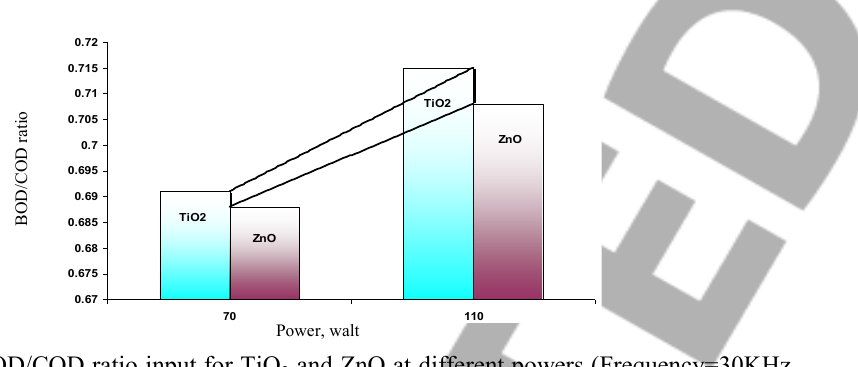
Figure 2 . BOD/COD ratio input for TiO concentration= 5 mg/L, pH=3).